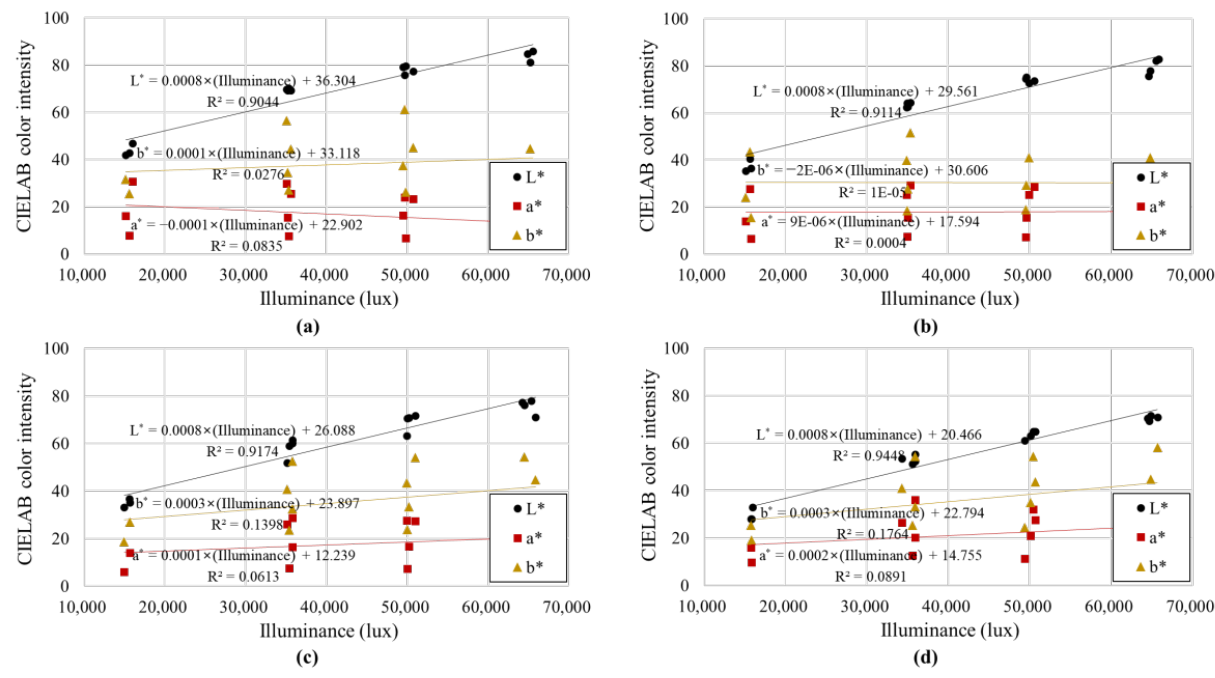
Figure 10. Mode CIELAB color intensities according to the illuminance of light: ( a ) Jumunjin sand, ( b ) Anseong soil, ( c ) Yongin soil, and ( d ) Gwanak soil.